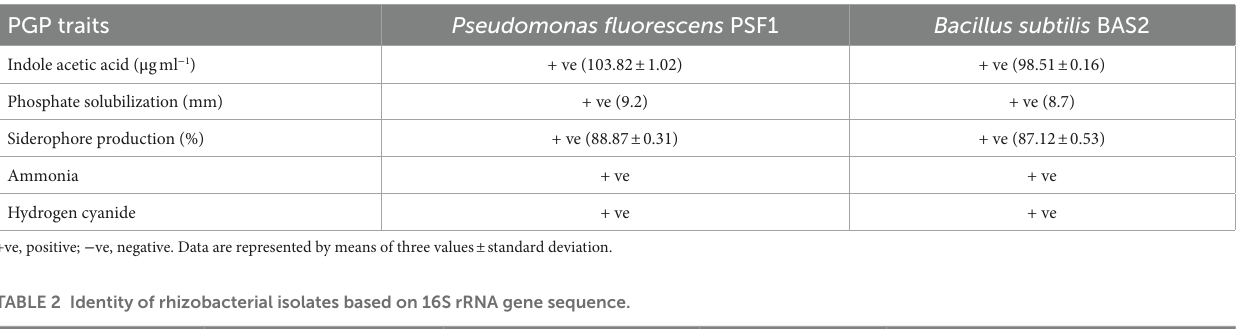
TABLE 1 Functional screening of selected rhizobacteria for in vitro PGP activities.